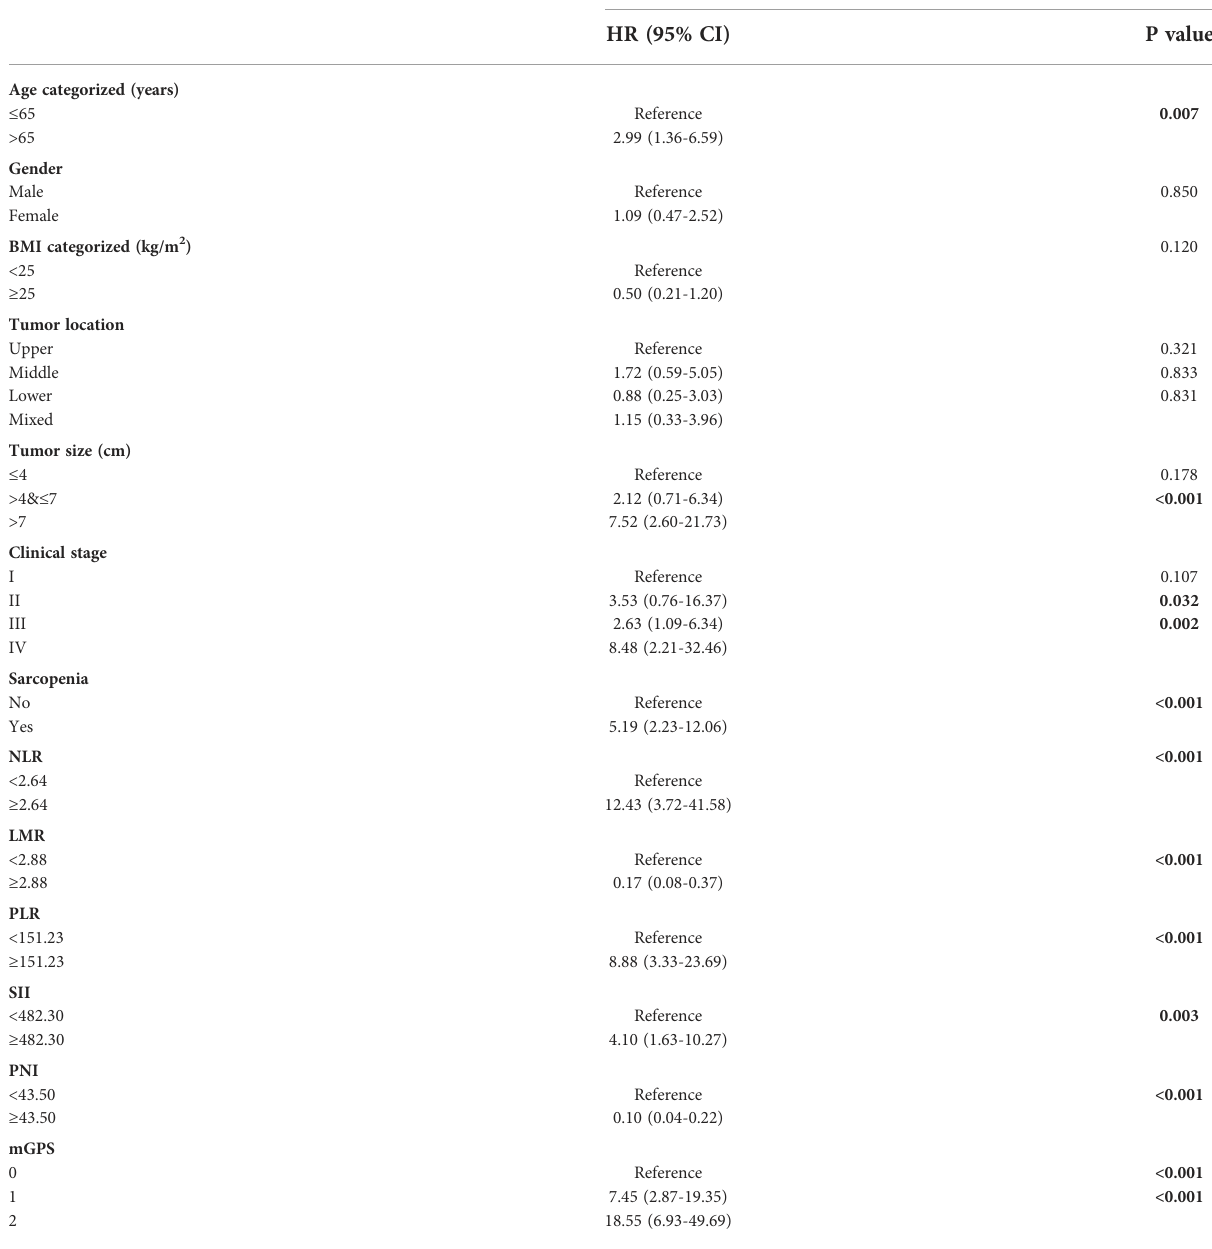
TABLE 3 Univariable Cox hazards regression analysis of clinicopathologic variables in relation to OS of RCC patients following nephrectomy.